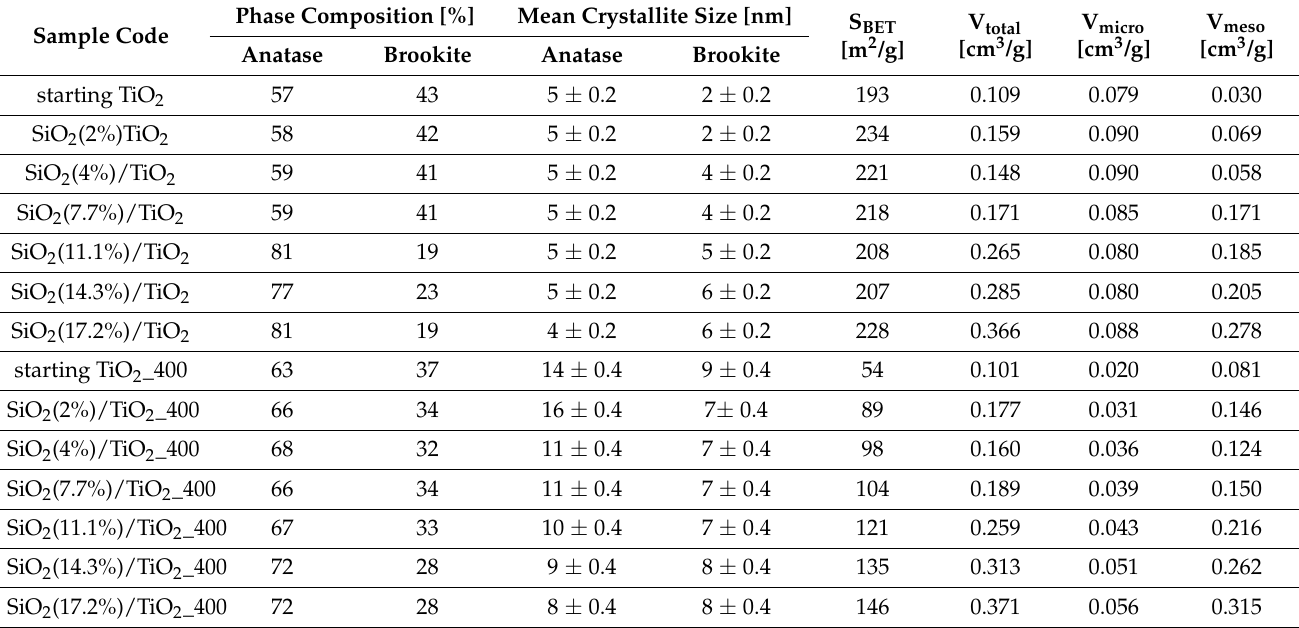
Figure 2. XRD patterns of starting TiO 2 and silica-modified TiO 2 prior ( A ) and after heat treatment ( B ). Table 1. XRD phase composition, average crystallites size, specific surface area and pore volume distribution of starting TiO 2 and silica-modified photocatalysts.